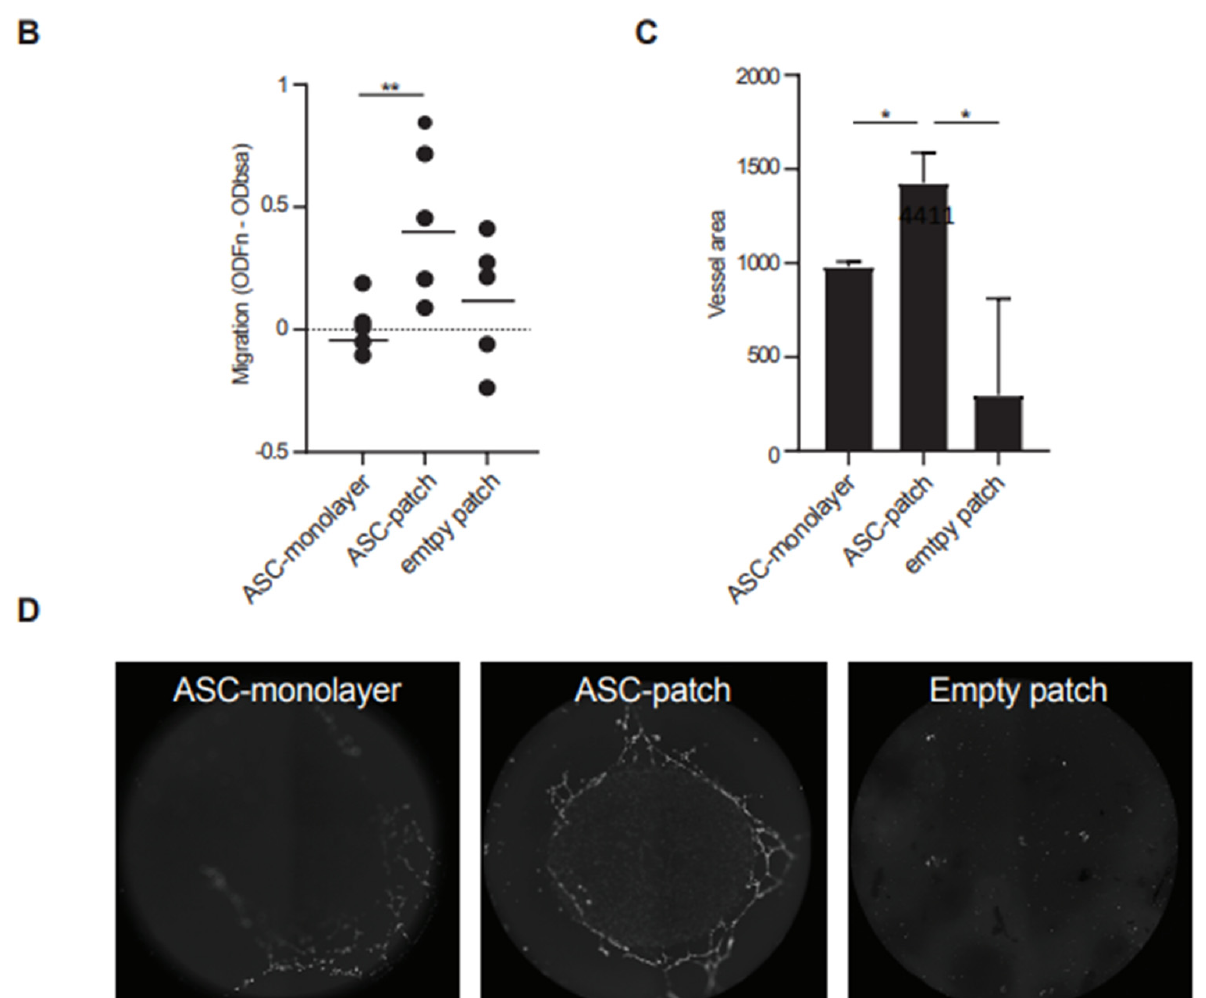
Figure 4. ASC-patch promotes neo-angiogenesis. ( A ) ASC-patches, fibroblast-containing patches, ASCs in single cell suspension (via a silicon ring) or empty gelatin sponges were deposited on the chorioallantoic membrane of fertilized chick eggs. Representative images of neovascularization are shown for each condition (left). The number of new vessels connections were quantified using ImageJ (right) (n = 6 assay). ( B ) A cell suspension of HUVEC was introduced in a Boyden chamber. Migration thorough a fibronectin-coated hemipermeable membrane towards the indicated conditioned media was determined (n = 5 assays). ( C ) Assessment of tubulogenesis of HUVEC in the presence of the indicated conditioned media. Tube area was quantified by the Cytation 5 image analysis software. (n = 6 assay) ( D ) Representative image of tube formation in the indicated conditioned media. Overall, in the figure: mean ± SD; non-parametric Mann–Whitney t test: * = p < 0.05, ** = p < 0.01.